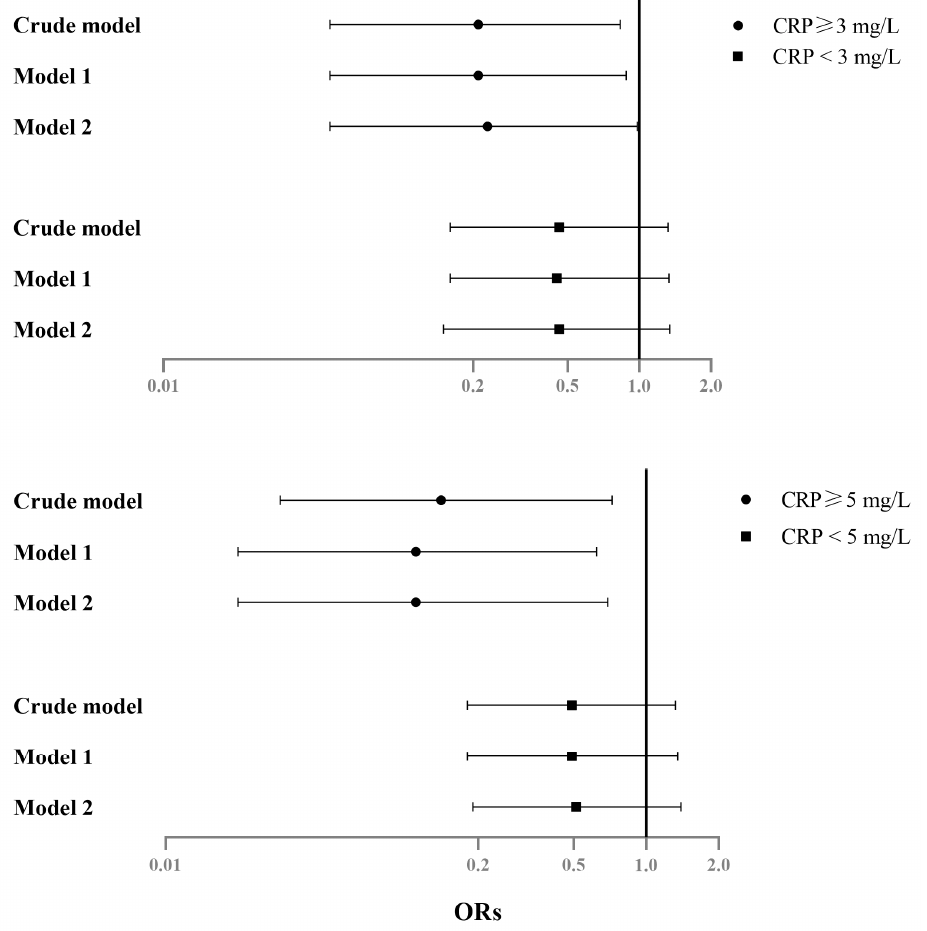
Figure 2. Forest plot for odds ratios (ORs) of depression with serum Mg levels, categorized by different CRP levels, NAHSIT 2005–2008. The error bars indicate a 95% CI. Model 1 was adjusted for age and sex. Model 2 was adjusted for statistically significant variables ( p < 0.05) in the univariate analysis (Table 1).